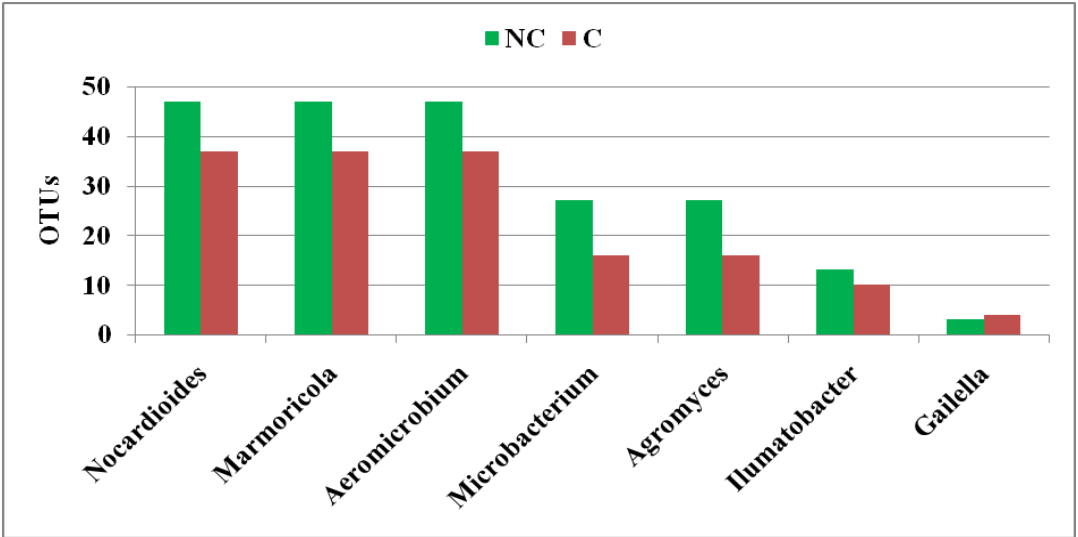
Figure A 3. Differences in dominant actinobacterial taxons at the genus level between the NC and C soils.